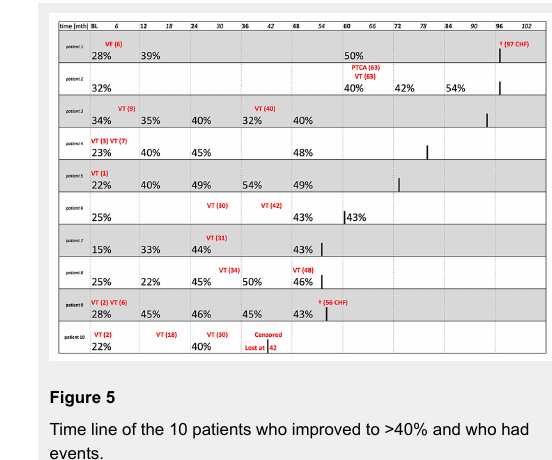
Time line of the 10 patients who improved to >40% and who had events. Brackets indicate time from implantation in months. † = death; BL = baseline; CHF = congestive heart failure; VF = ventricular fibrillation; VT = ventricular tachycardia